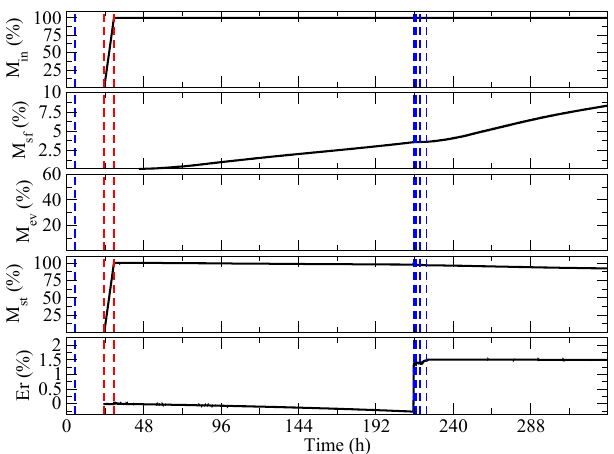
Figure 8. Simulated mass balance results for α l = 0 . 001m when the sink term is used to perform evaporation and the correction term f c added to the transport equation is used to force all the isotopic mass to stay in the system (simulation k of Table 3). From top to bot- tom: 2 H mass that enters the system, M in (normalized with respect to the total mass added to the system during the simulation); that exits through the seepage face, M sf ; that exits through evaporation, M ev ; and that remains in storage, M st . The bottom graph shows the cumulative mass balance error E r = (M in − M sf − M ev − M st ) . The vertical dashed lines indicate the timing of the three pulses of rain (red when the water is 2 H -enriched and blue when it is